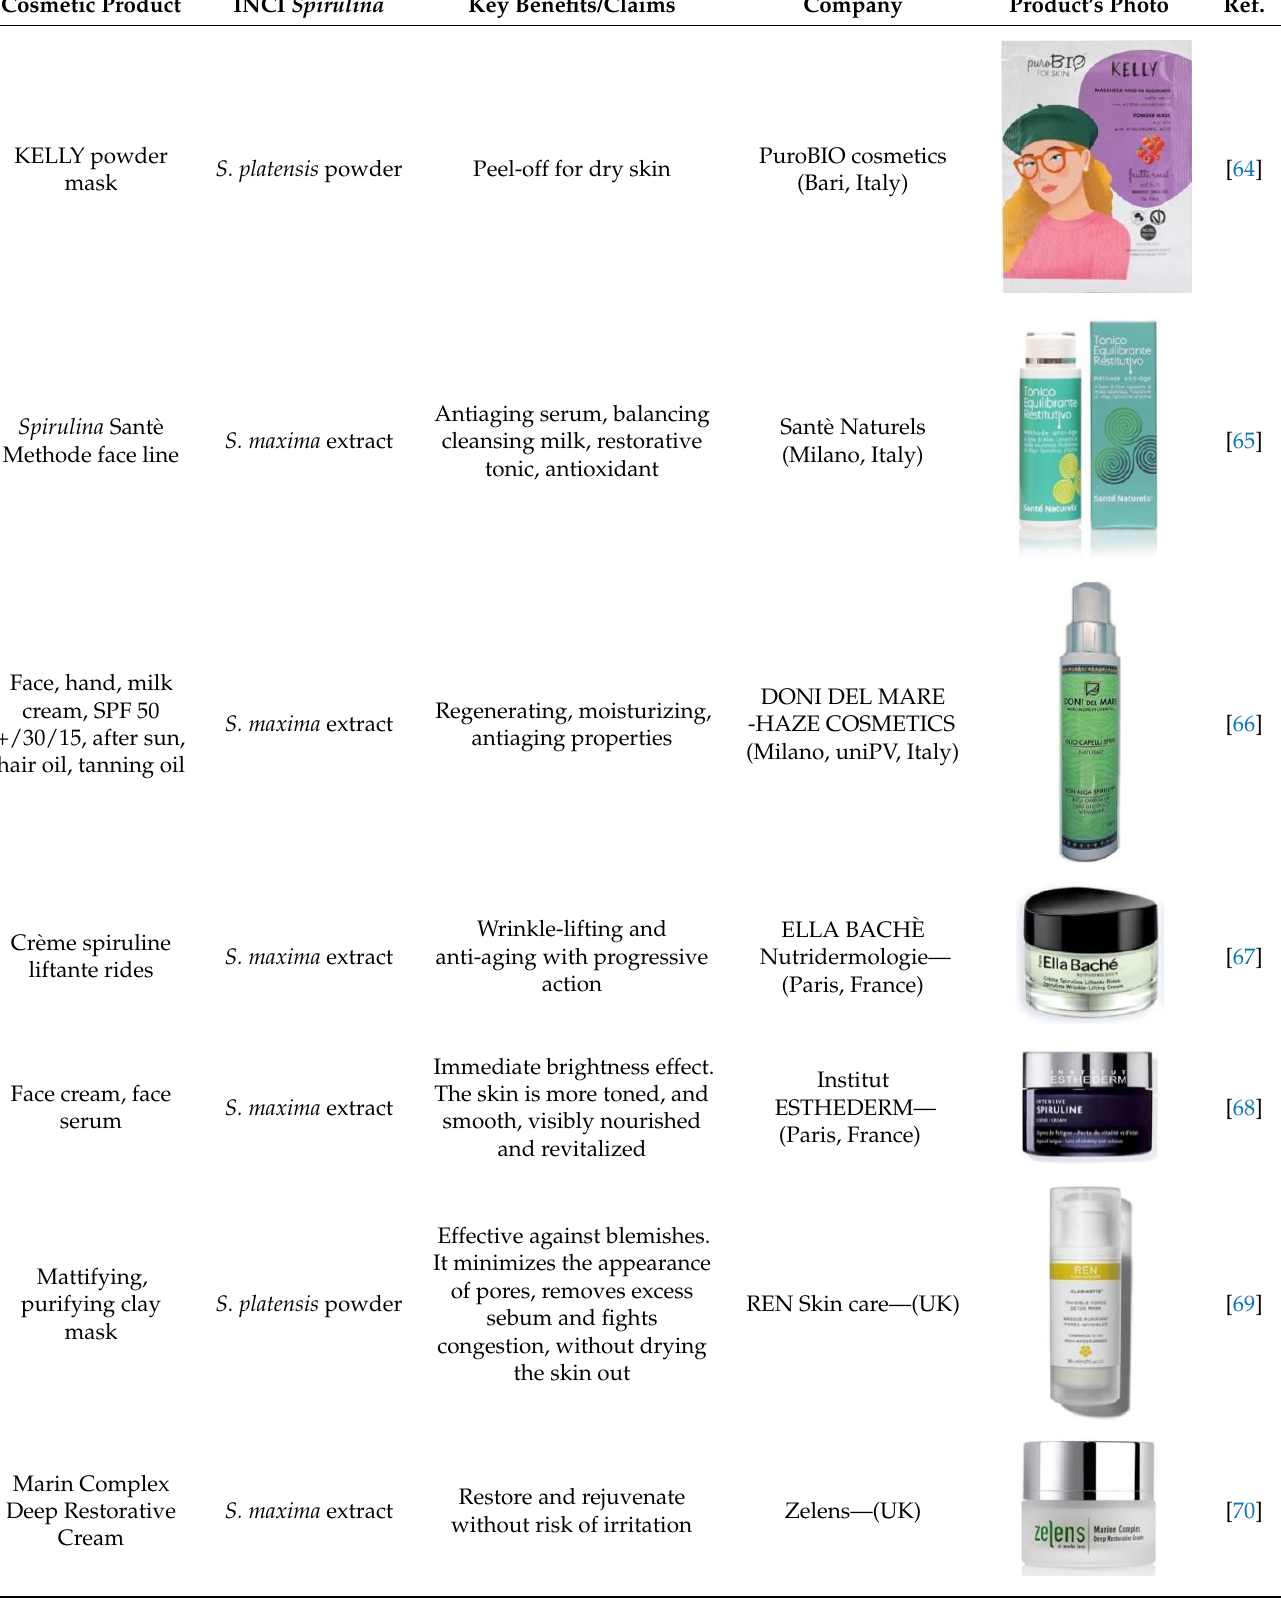
Table 8. Spirulina benchmark on skin care products.